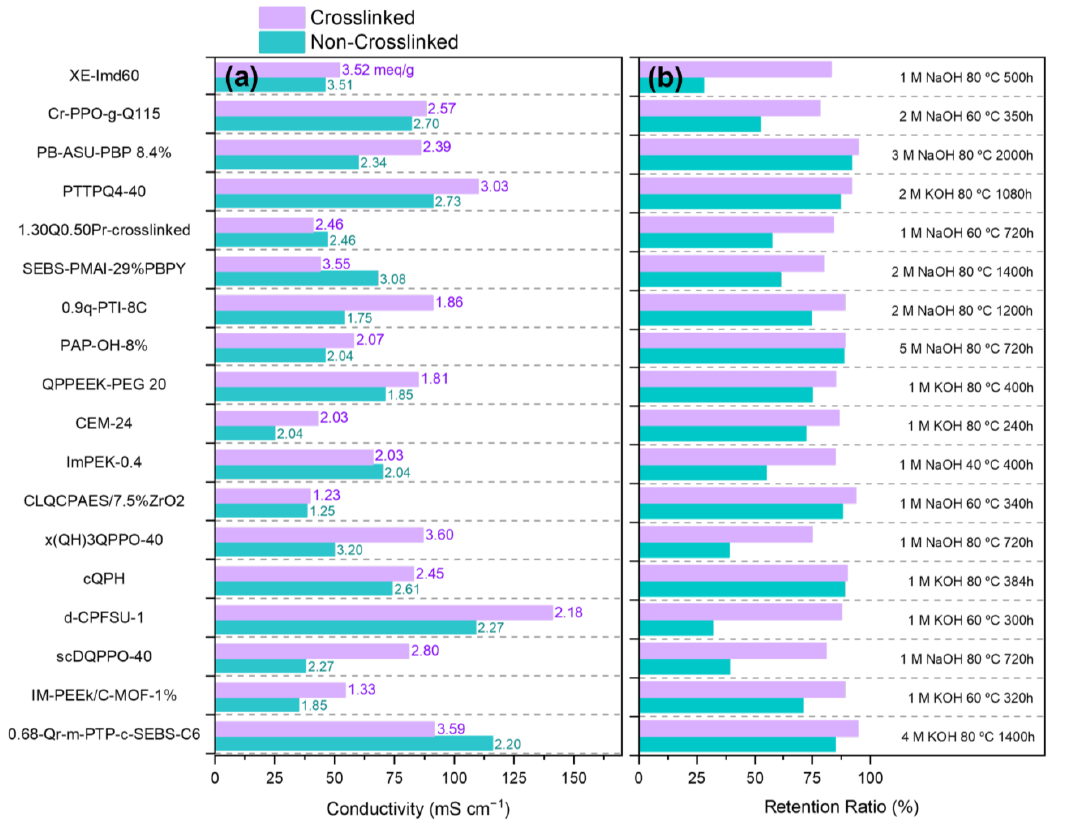
Figure 4. Comparison of recently reported crosslinked (purple) and non-crosslinked (cyan) AAEM analogs. In panel ( a ) bars indicate respective hydroxide conductivities at 60 °C, and the corresponding text labels are measured IEC values. Panel ( b ) shows retention ratios of hydroxide conductivity after exposure to the alkaline stability protocol (black text). XE-Imd60 [70], Cr-PPO-g-Q115 [78], PB-ASU-PBP 8.4% [81], PTTPQ4-40 [95], 1.30Q0.50Pr-crosslinked [96], SEBS-PMAI-29%PBPY [97], 0.9q-PTI-8C [98], PAP-OH-8% [99], QPPEEK-PEG20 [100], CEM-24 [101], ImPEK-0.4 [102], CLQCPAES/7.5%ZrO2 [103], x(QH)3QPPO-40 [104], cQPH [105], d-CPFSU-1[106], scDQPPO-40[107], IM-PEEk/C-MOF-1%[108], 0.68-Qr-m-PTP-c-SEBS-C6 [109].